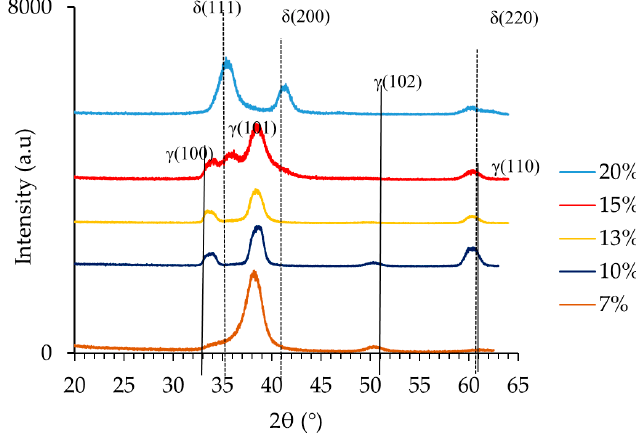
Figure 1. Low-angle XRD of Ta–Si–N films deposited with varying the N 2 /(N 2 + Ar)